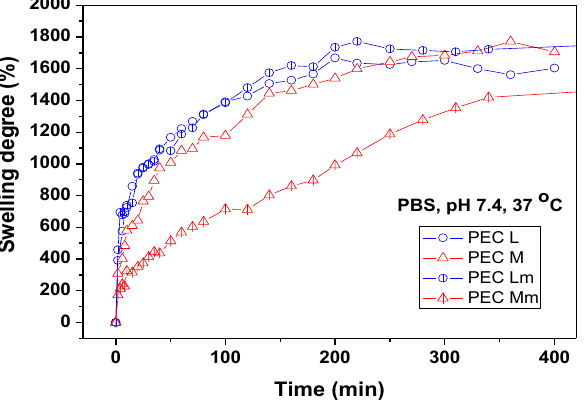
Figure 4. Swelling behavior of PEC (polyelectrolyte complexe) sponges in PBS (phosphate buffered saline) pH 7.4 at 37